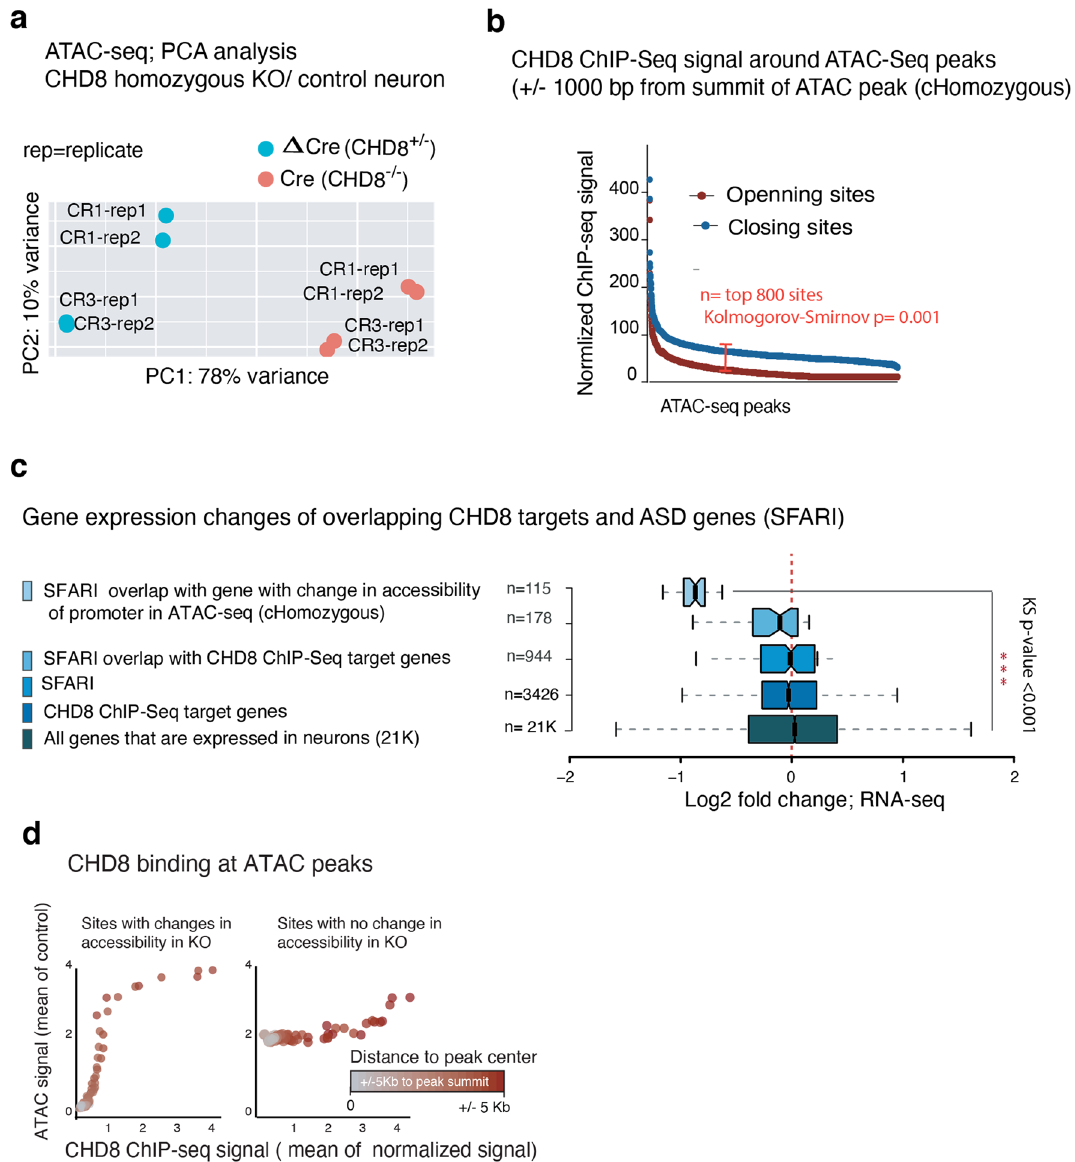
Figure 17. Analysis of ATAC-Seq and RNA-Seq from homozygous CHD8 knockout neurons. ( a ) Principal component analysis (PCA) for ATAC-seq signal from control (ΔCre) and homozygous KO (Cre) neurons and the separation of the samples based on the genotype in PC1. One embryonic stem cell line (CR1) and the One iPSC line (CR3), and two technical replicates for each line are used in the experiment. ( b ) CHD8 binding on sites of chromatin that exhibit accessibility change in ATAC-seq- experiment (homozygous KO) (CHD8 signal is taken from ± 1000 bp of the summit of ATAC-seq DE peak). ( c ) Boxplots represent log2 scaled fold change in RNA expression of CHD8 target genes including overlapping with autism gene list and control gene list (two- sample Kolmogorov–Smirnov test). ( d ) Analysis of CHD8 binding at CHD8 KO ATAC-seq sites with differential accessibility and in regions with no change. The average ATAC-seq signal is calculated from control